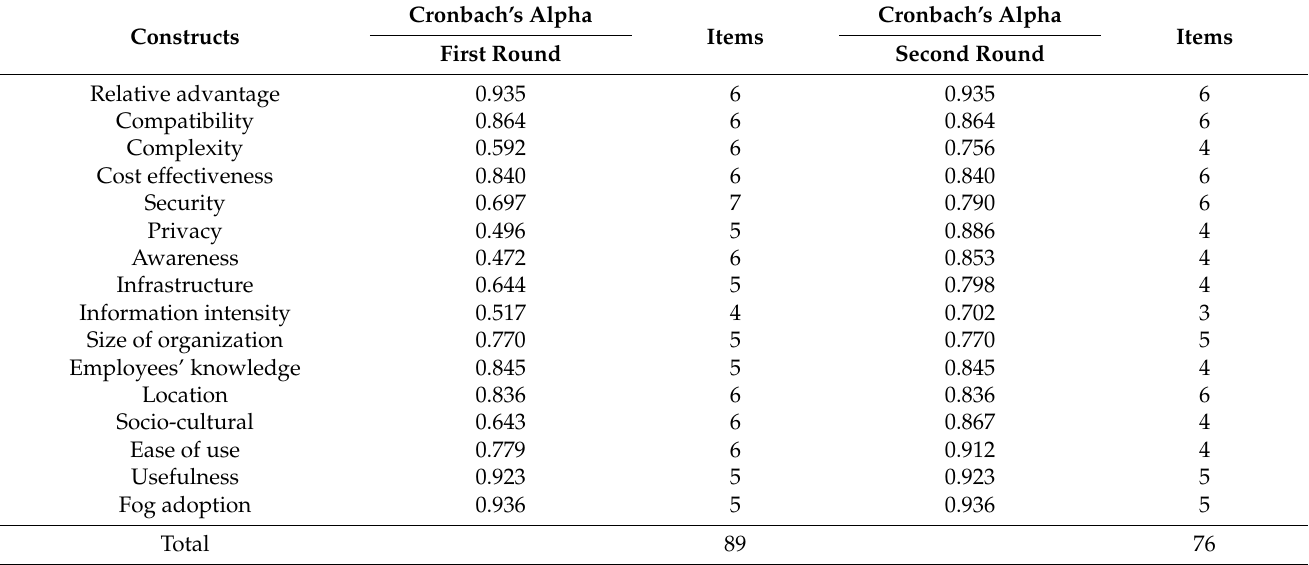
Table 2. Reliability